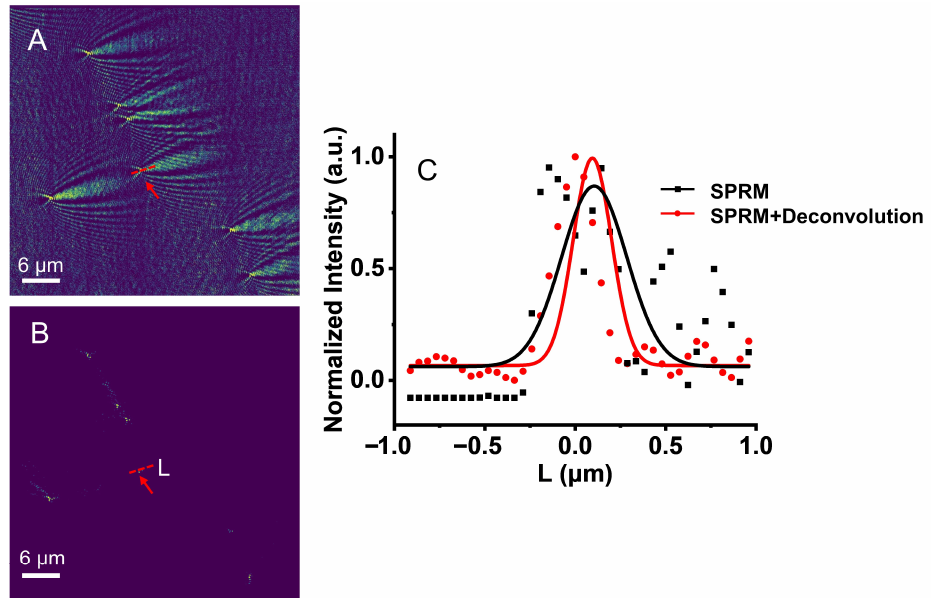
Figure 6. Reconstruction and analysis for SPRM imaging of 200 nm polystyrene nanospheres. ( A ) SPRM image of 200 nm polystyrene nanospheres; ( B ) reconstruction images; ( C ) intensity distribution in L direction.